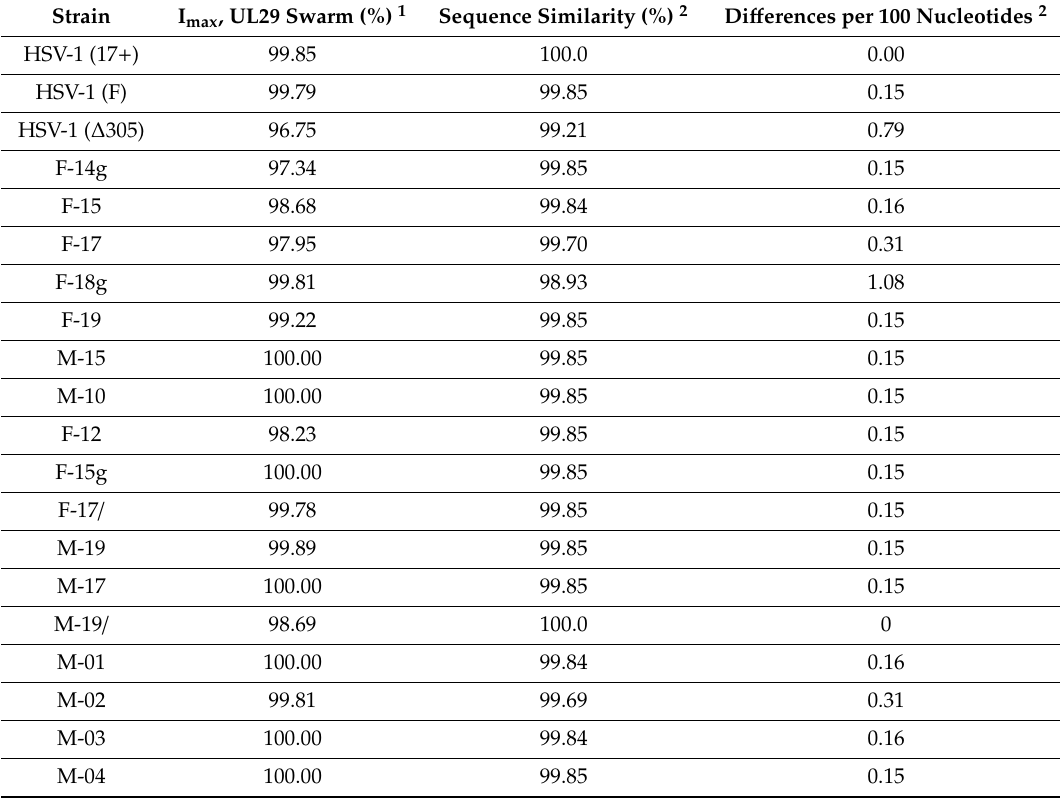
Table 3. Maximal inhibition of viral shedding (I max ) in response to UL29 siRNA treatment and sequence similarity with the UL29 siRNA swarm